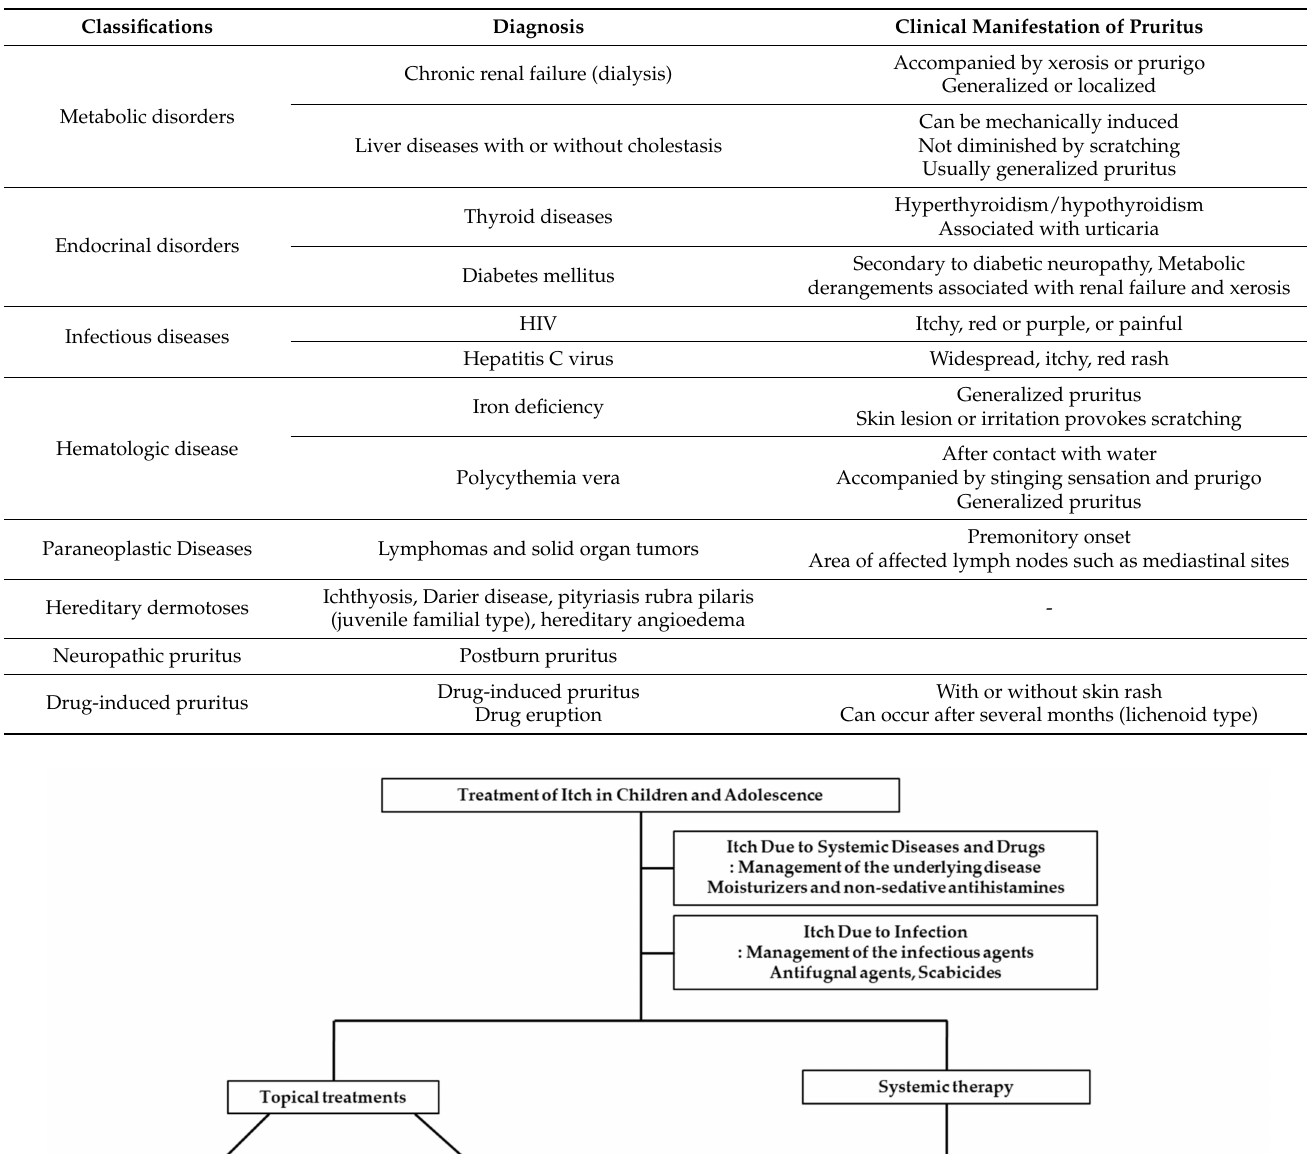
Table 2. Causes and characteristics of pruritus in various childhood diseases.